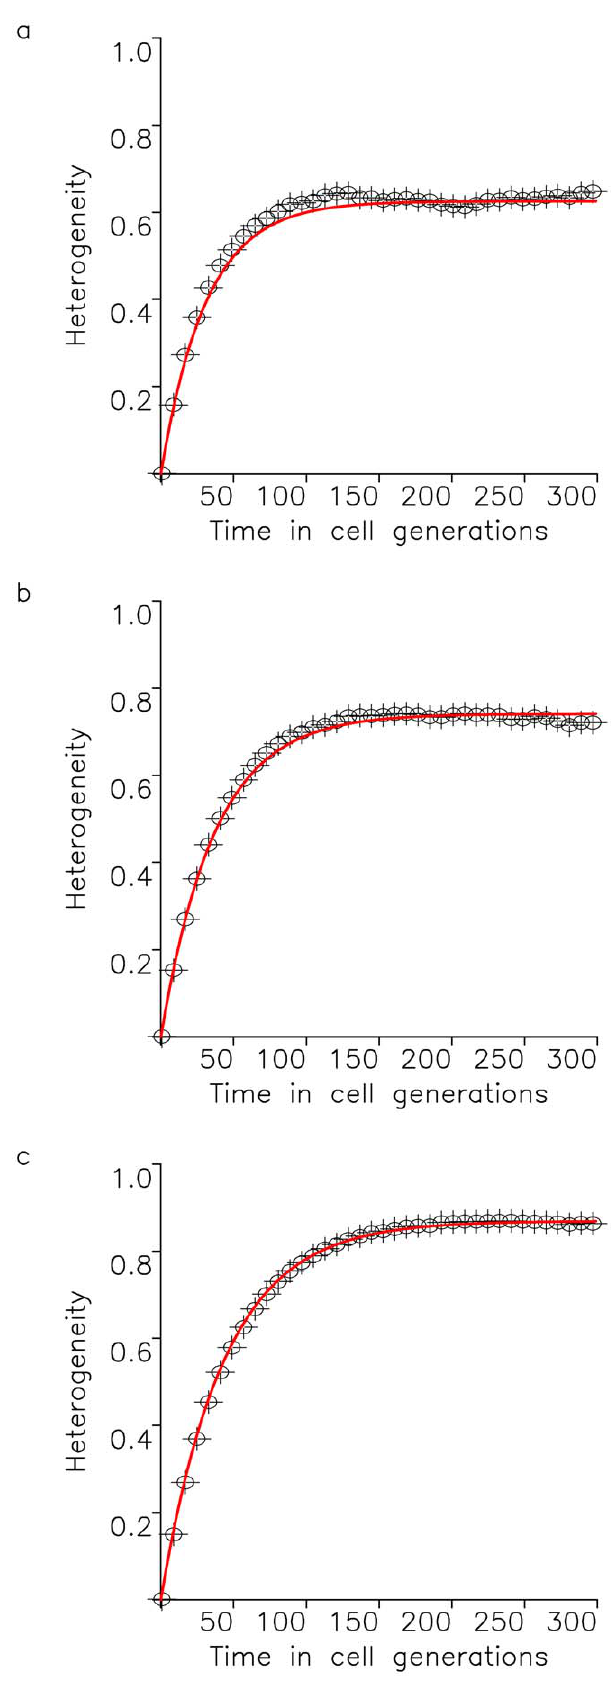
Figure 5. Tumor heterogeneity due to continuously arising neutral and advantageous variation. A cell population of fixed size, N , accumulates neutral mutations at rate u per cell division and advantageous mutations at rate v per cell division. All neutral mutants have growth rate R and death rate D , while a cell with k advantageous mutations has growth and death rates of R (1 z S = R ) k and D . The figure shows the fit of the exact stochastic computer simulation of this process with equation (15). In the simulation, heterogeneity is defined as Simpson’s index, equation (1). Parameters are N ~ 1000 , R ~ D ~ 1 , I ~ 10 4 , u ~ 10 { 2 , S ~ 1000 , and v ~ 10 { 5 in (a), v ~ 5 : 10 { 6 in (b), and v ~ 10 { 6 in (c), and results are averaged over 1000 simulation runs.